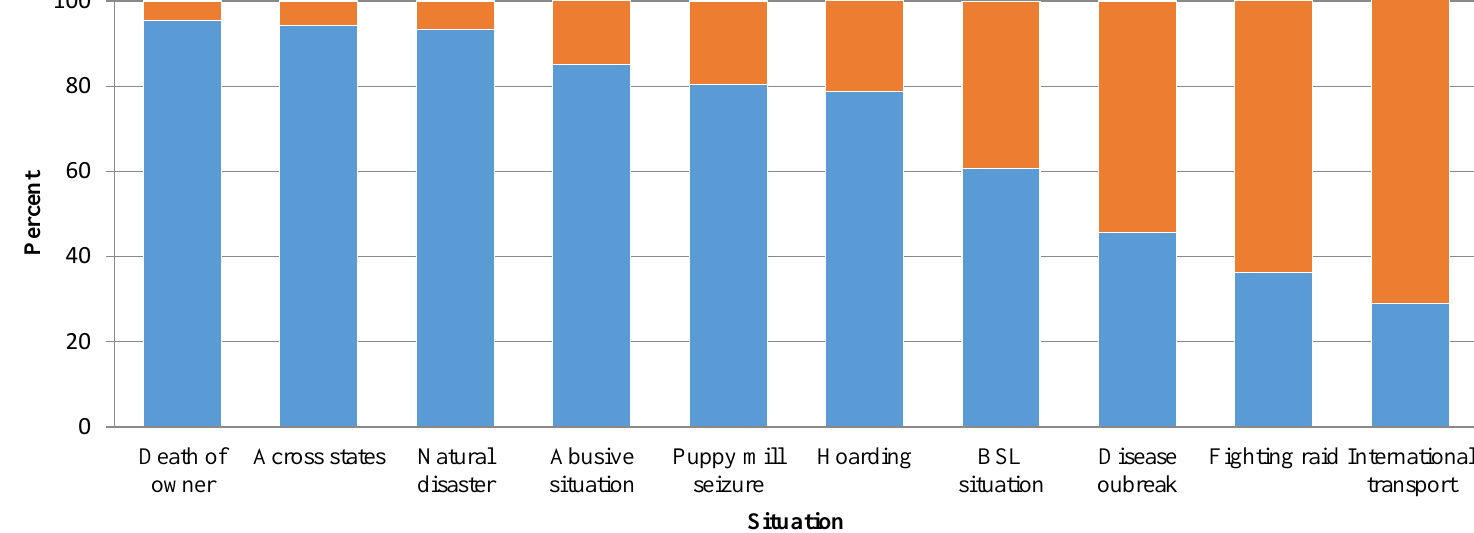
Figure 2. Likelihood of organizations to transfer in dogs in need of rehoming due to various circumstances. Blue bars represent likely, and orange bars represent unlikely. BSL, breed-specific legislation.